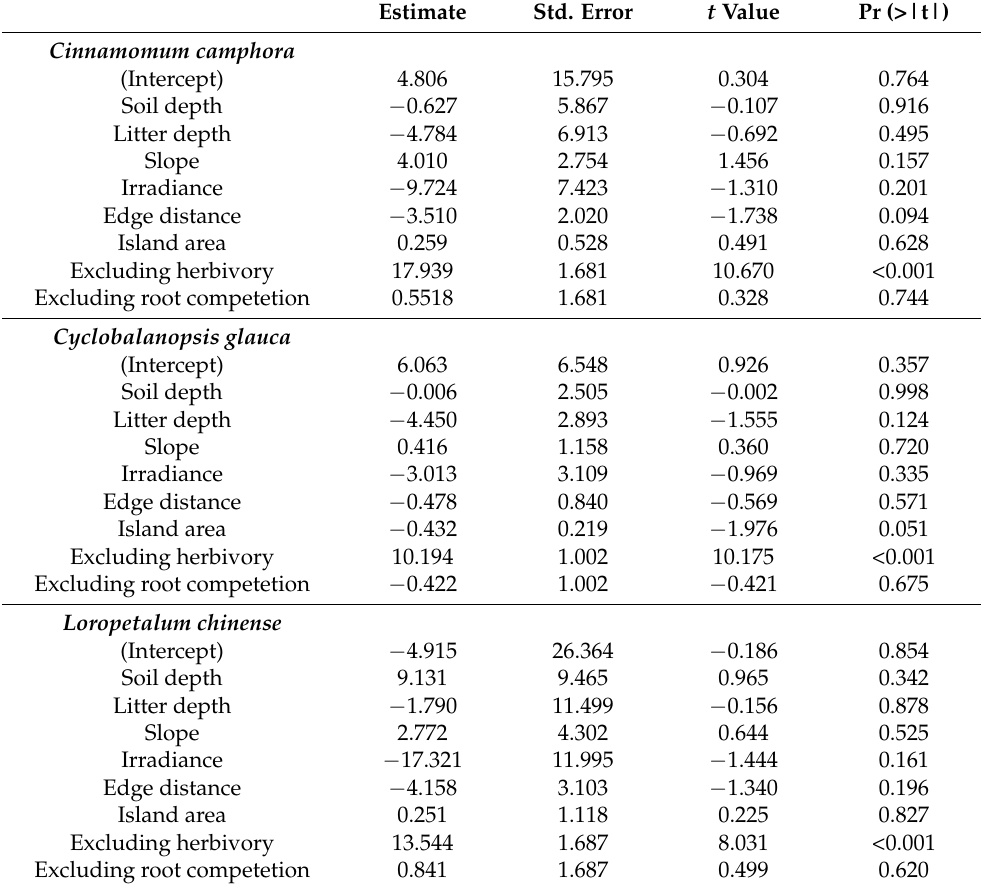
Table 3. Linear mixed-effects model (LME) results. The response variable was the proportion of surviving seedlings for each species. Six abiotic variables (soil depth, litter depth, slope, irradiance, edge distance, and island area) and one categorical variable indicating the treatment were used as explanatory